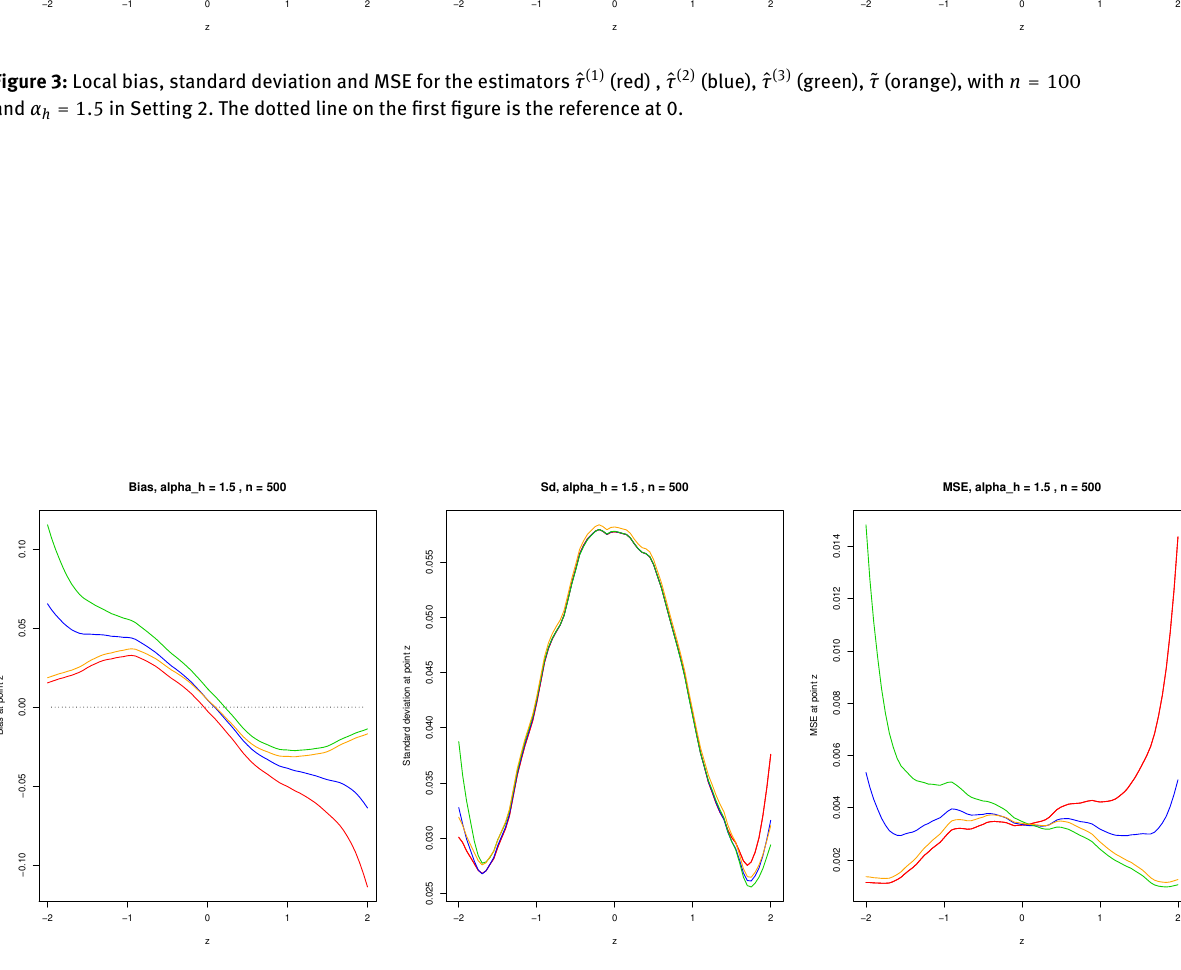
Figure 4: Local bias, standard deviation and MSE for the estimators ˆ τ (1) (red) , ˆ τ (2) (blue), ˆ τ (3) (green), ˜ τ (orange), with n = 500 and α h = 1.5 in Setting 2. The dotted line on the first figure is the reference at